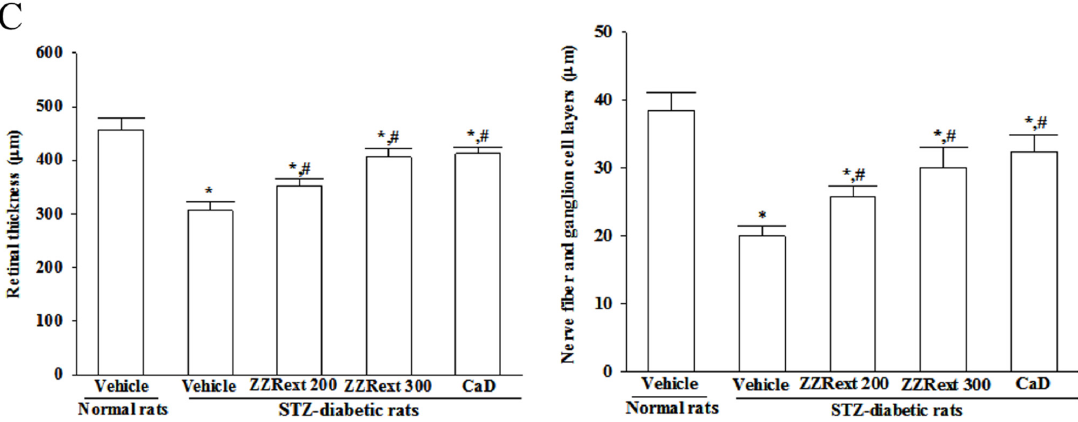
Figure 1. Effects of treatments on vascular permeability and retinal histology. Streptozotocin-induced (STZ)-diabetic rats were administered 200 mg/kg/day ZZRext (STZ